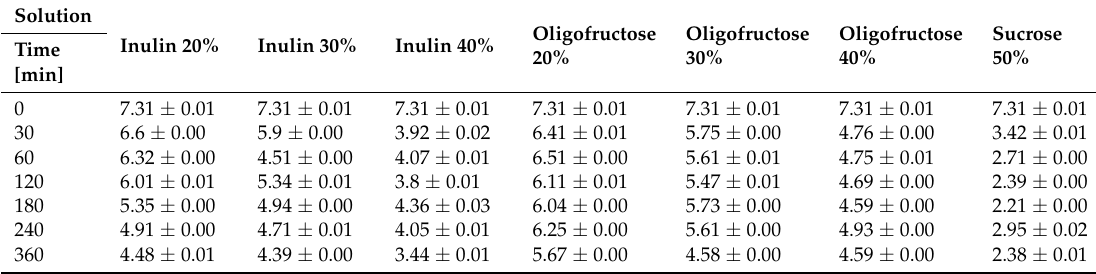
Table 2. Water content (g/g d.m.) in apples during OD in different solutions (continued). Solution Inulin 20% Inulin